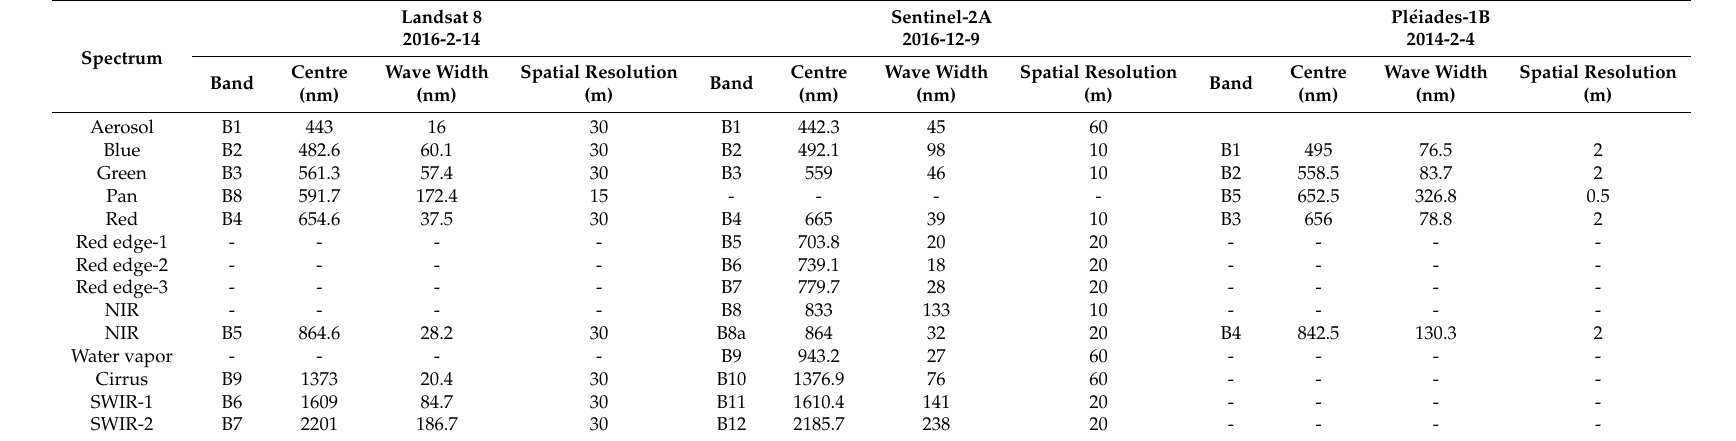
Table 1. The characteristics of Landsat 8, Sentinel-2 and Pl é iades-1